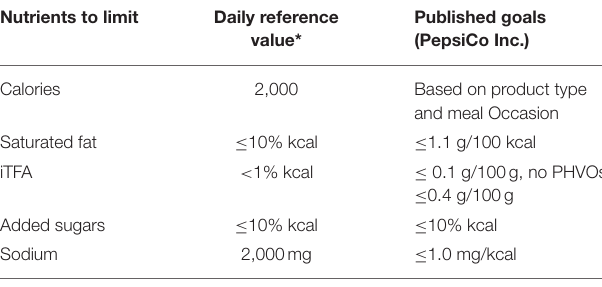
TABLE 1 | Levels for nutrients to limit.